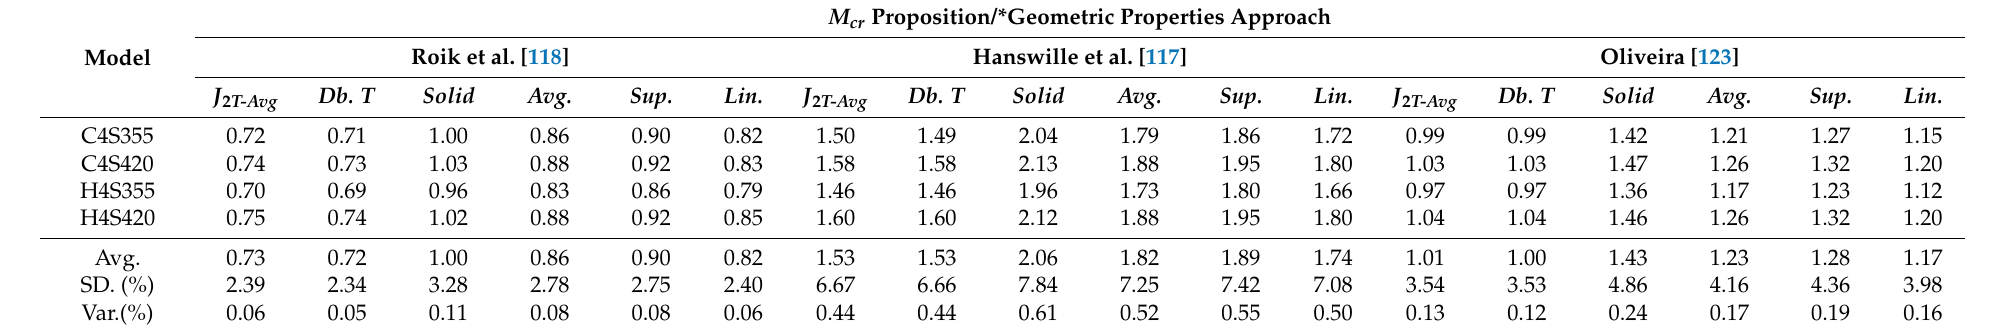
Table 14. M u-Theoretical / M u-test obtained by the calculation procedure of Salah’s M u proposition [58] with M cr calculation based on the U-frame